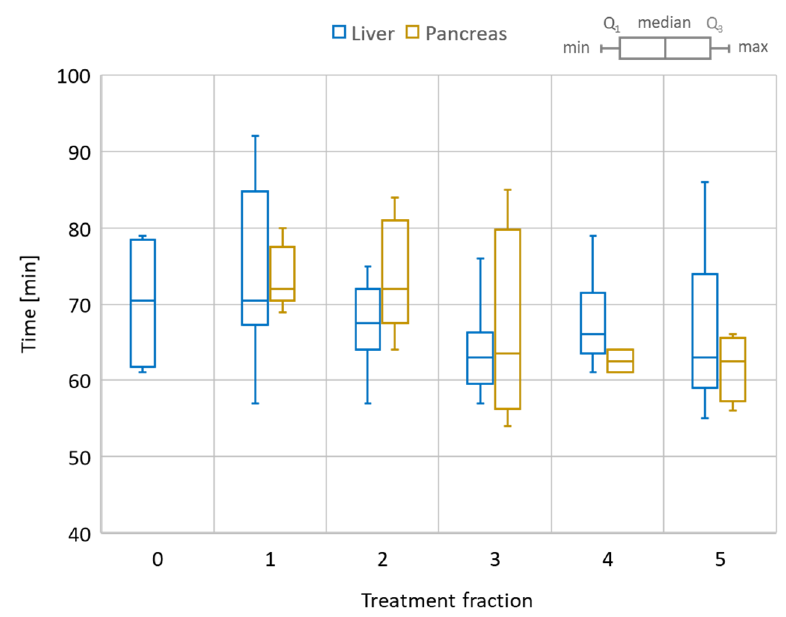
Figure 6. Total session time for the online adaptive workflow. Comparison between liver and pancreas cases. Liver also includes the dry-run (Day 0) session time as a reference. The box plot shows the min/max/median values as well as the first (Q 1 ) and third (Q 3 ) quartile of the session time distribution.